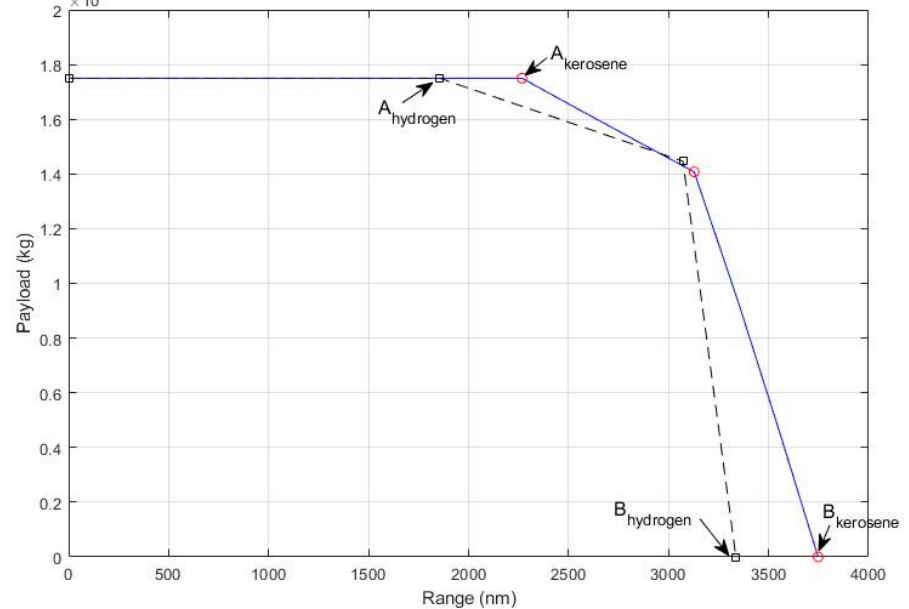
Figure 1. Payload range diagram for kerosene (solid line) and hydrogen fuelled (dashed line) air-